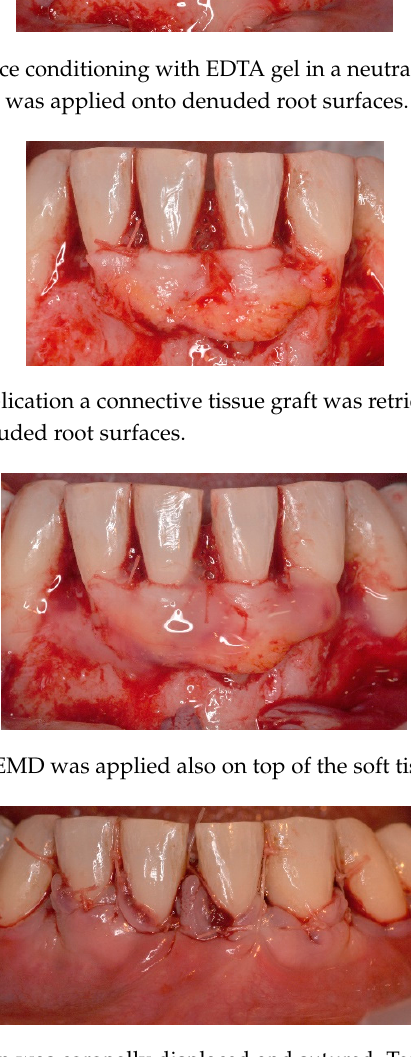
Figure 8. The single buccal flap was coronally displaced and sutured. Tenting sutures were also placed coronally to the contact area to further stabilize the buccal tissues.